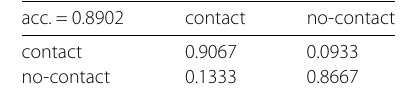
Table 7 Confusion matrix with accuracy of the BiLSTM-logi for event reconstruction acc. = 0.8902